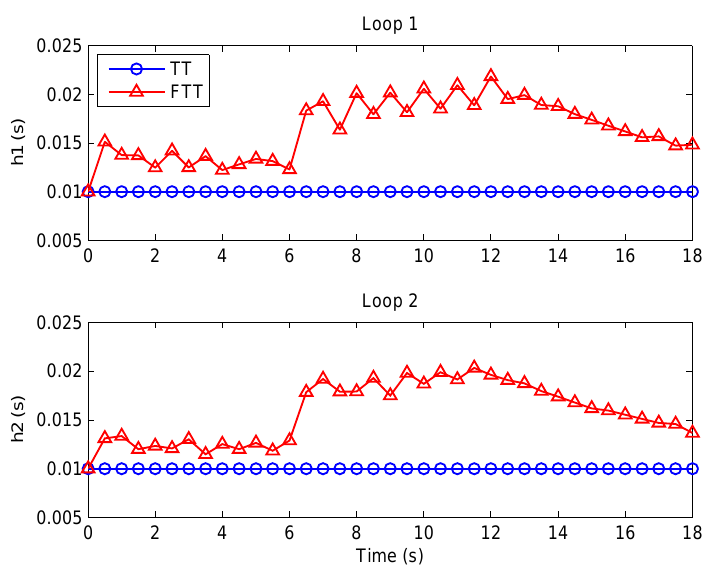
Figure 8. Sampling period under slight